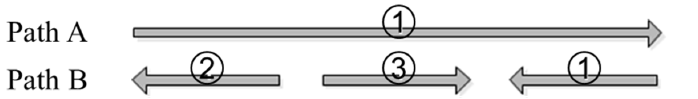
Figure 7. Two welding sequences.